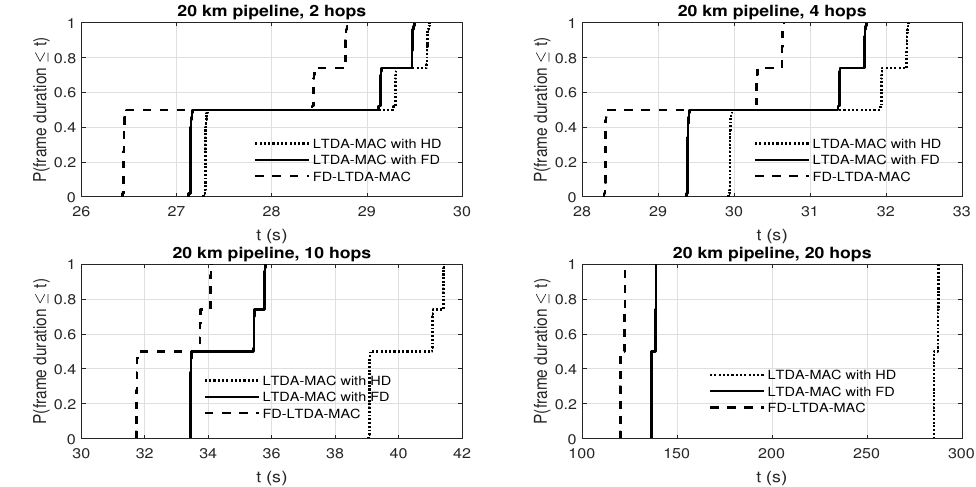
Figure 11. Frame duration cdfs of LTDA-MAC with HD nodes, LTDA-MAC with FD nodes, and FD-LTDA-MAC for a 20 km